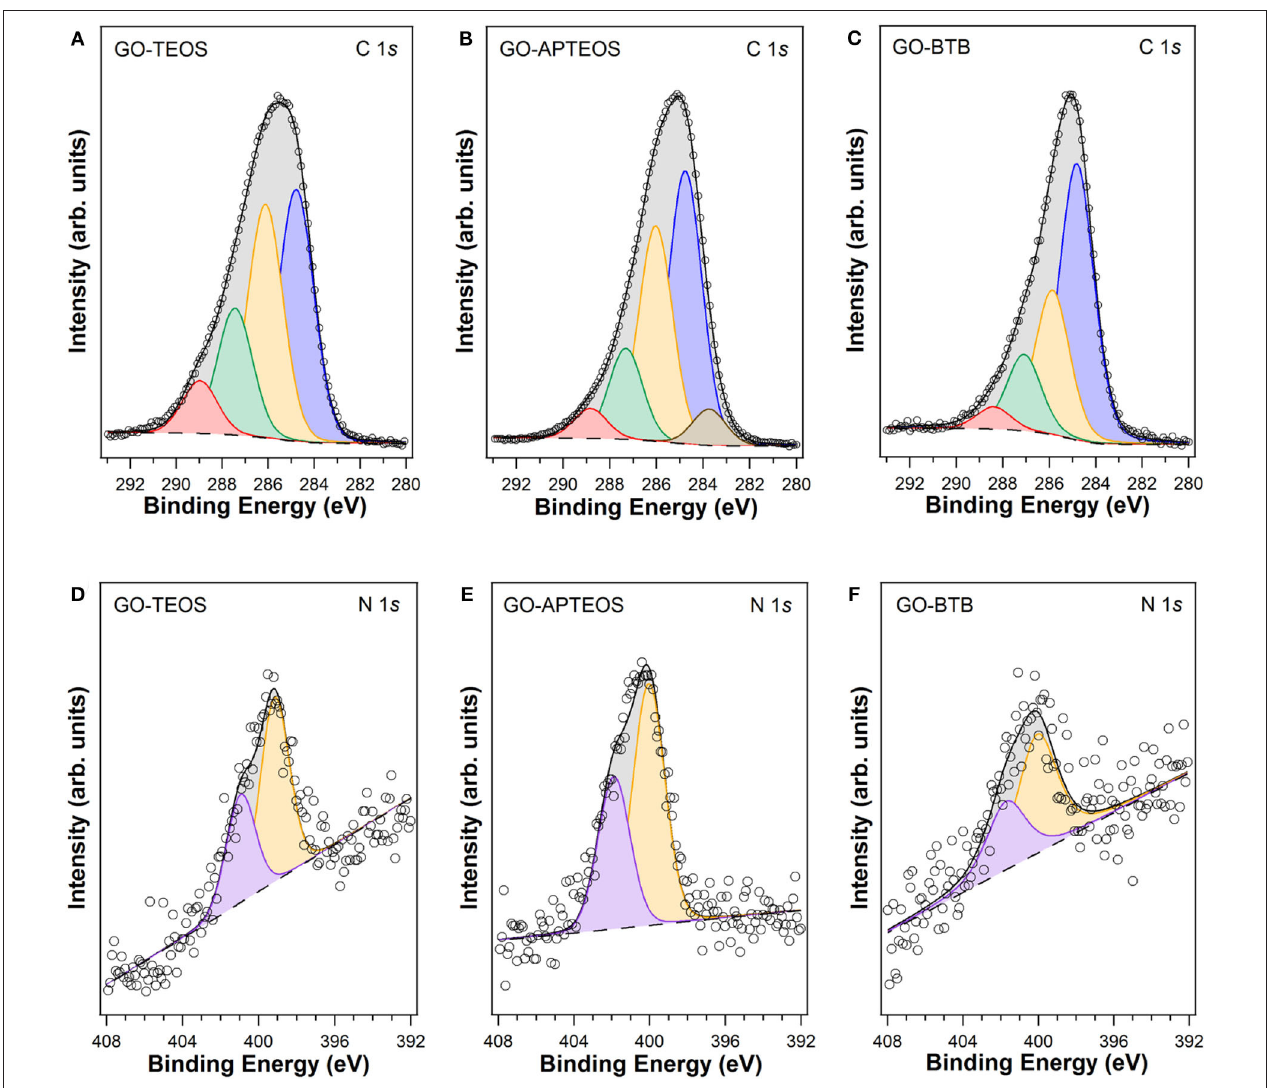
FIGURE 8 | XPS spectra of the C1 s (A–C) and N1 s (D–F) core level regions of heterostructures prepared by silylation of organo-modified graphene oxide with 1,4-Bis(triethoxysilyl)-benzene (GO-BTB), with (3-aminopropyl)triethoxysilane (GO-APTEOS) and with tetraethylorthosilicate (GO-TEOS) (dots) and corresponding fits (full lines); for the differently colored peaks see